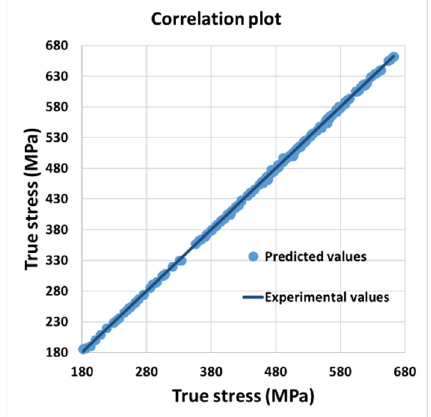
Figure 8. E xperimental data (line) vs. predicted data (dots).